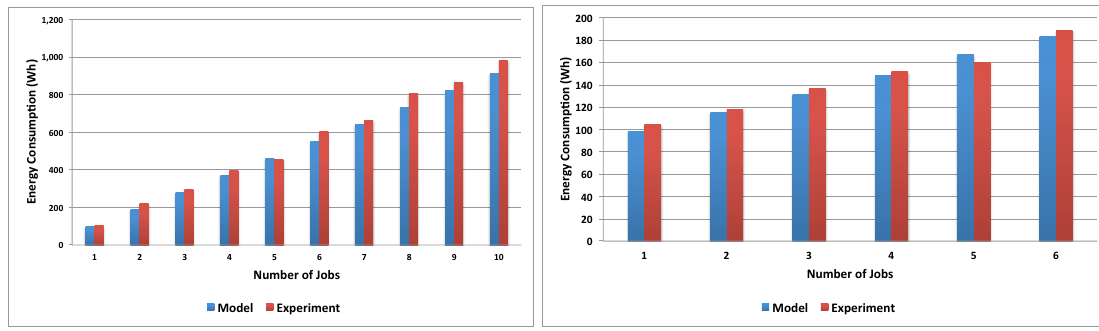
Figure 11. Energy consumption for batch configurations one VM for all ( left ) and one VM for each ( right ).